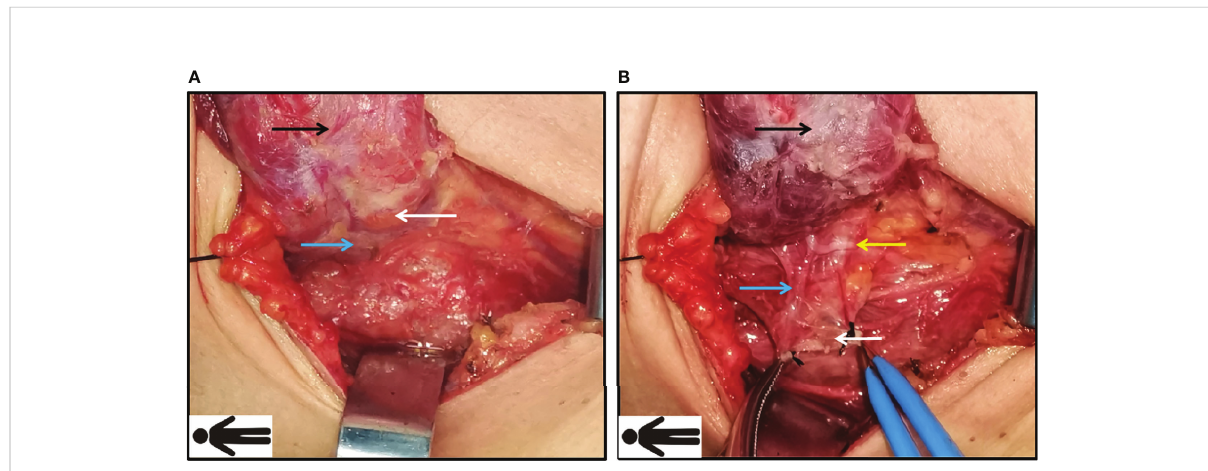
FIGURE 4 Preservation of inferior parathyroid gland during Fang ’ s capillary fascia preservation right recurrent laryngeal nerve (F-R-RLN) dissection technique. (A) Inspect the inferior parathyroid glands (the white arrow) and its blood supply (blue arrow) after raising the lobe. (B) Protect and raise sternothyroid ligament outwards and downwards, creating a fan-like shape, in which the vertex is formed by the parathyroid and the parathyroid blood vessels; the sternothyroid ligament is intact. Black arrow: the right lobe of thyroid; white arrow: the inferior right parathyroid gland; blue arrow: the blood supply of parathyroid gland; yellow arrow: the recurrent laryngeal nerve (RLN) .